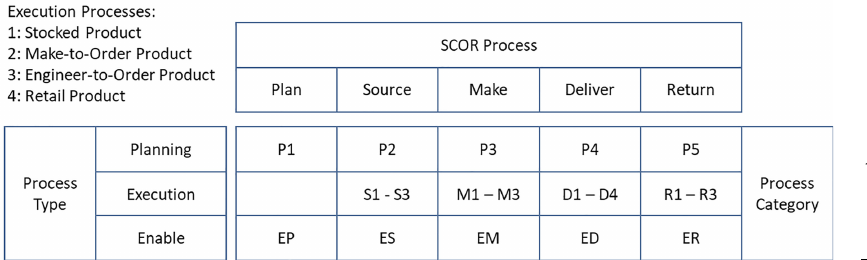
Figure 2. Summary